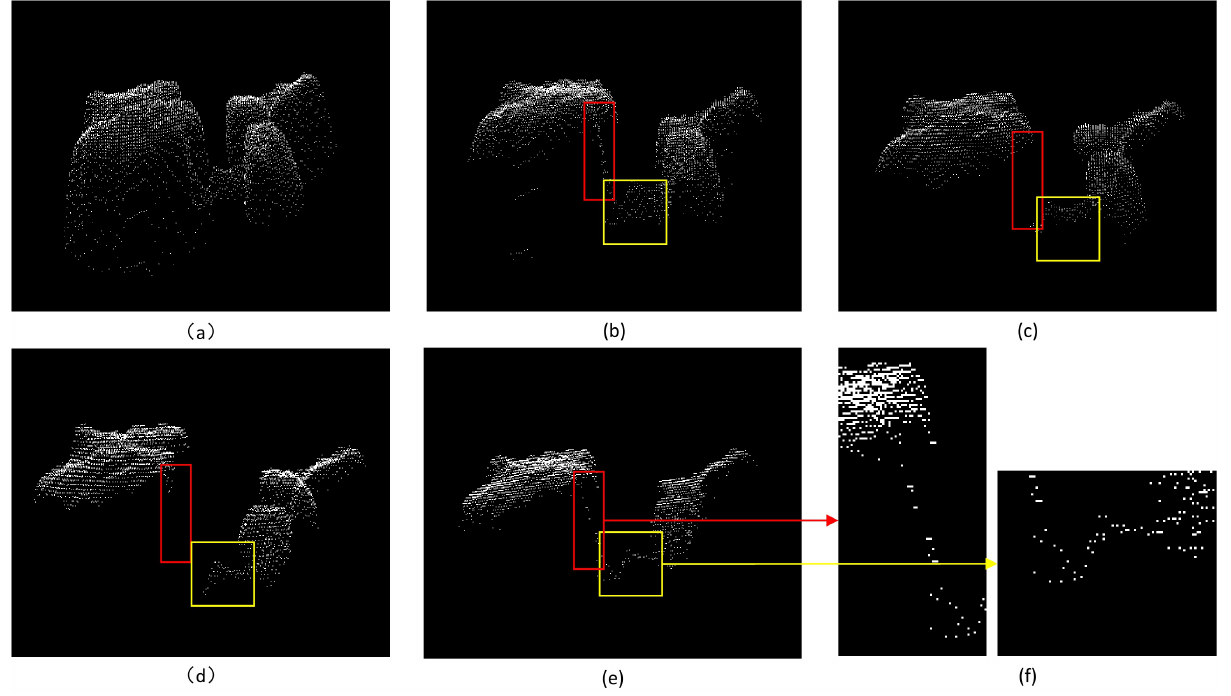
Figure 5. ( a ) The original point cloud with hover point noise. ( b ) Statistical filtering. ( c ) Radius filtering. ( d ) The domain maximum filtering of a two-dimensional depth map. ( e ) Our proposed filtering results. ( f ) denotes the local magnification of our method after